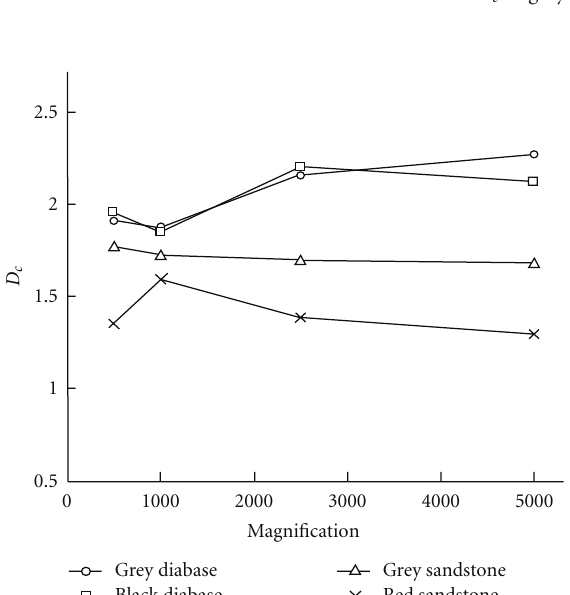
Figure 6: Fitted D c of grey diabase for di ff erent magnification.